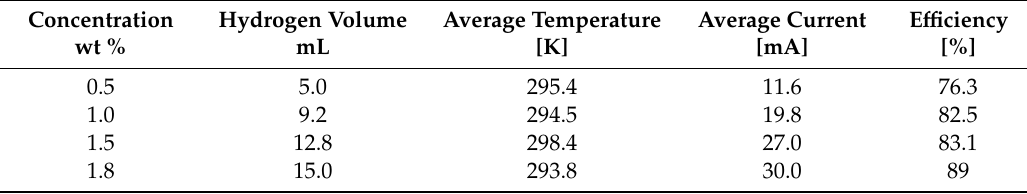
Table 1. Experimental results according to the concentration of